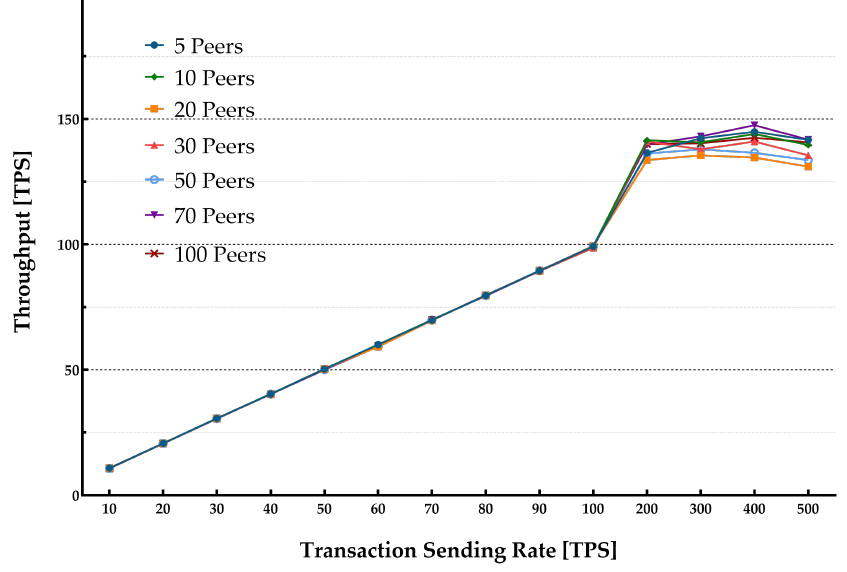
Figure 5. Transactions sending rate vs. throughput—a single host